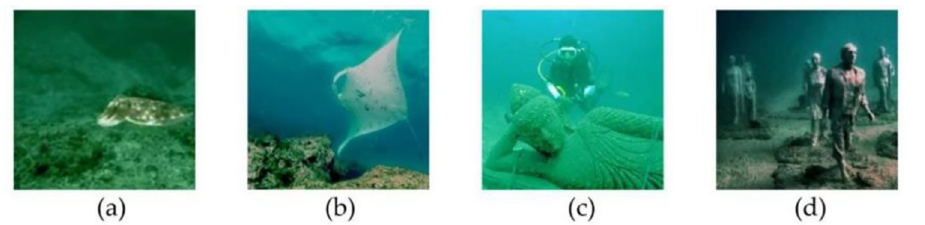
Fig 1. The original underwater images with low image